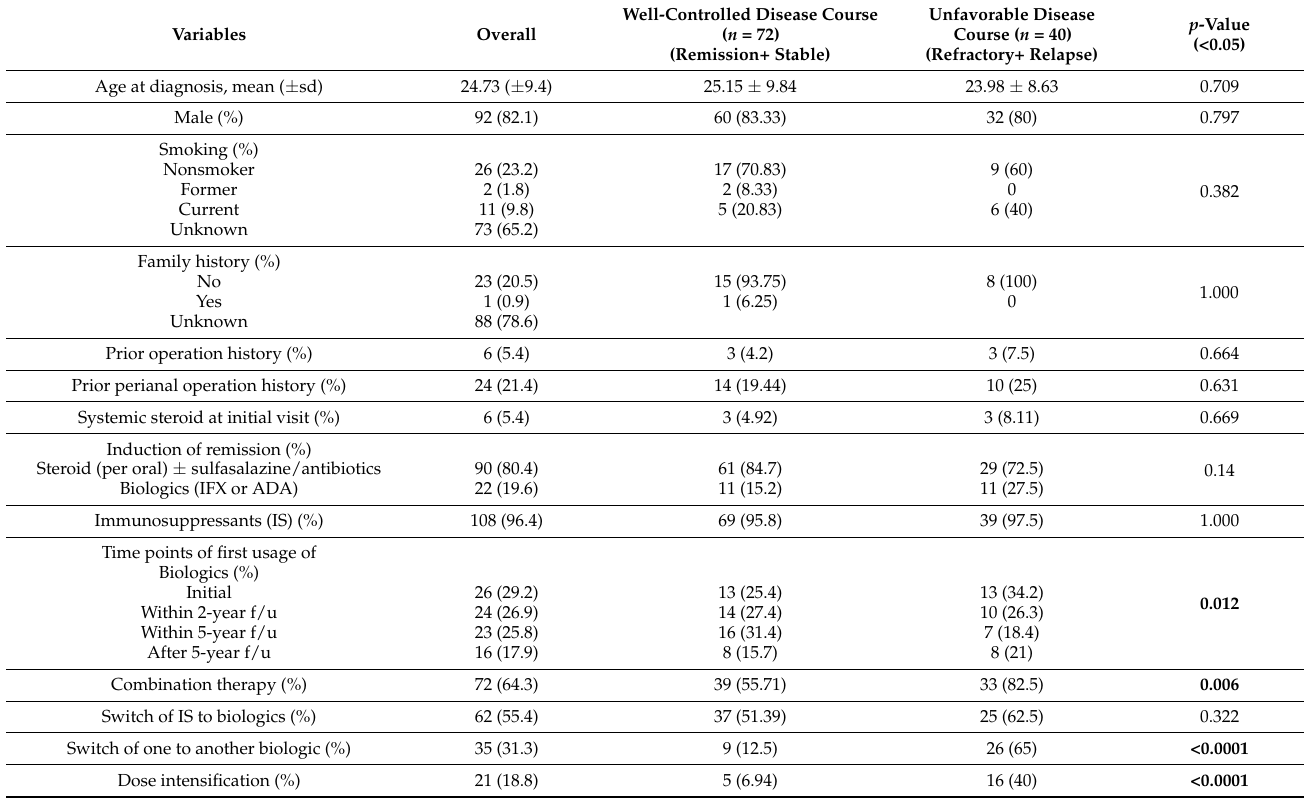
Table 2. Comparison of clinical characteristics of CD patients between well-controlled and unfavor- able disease